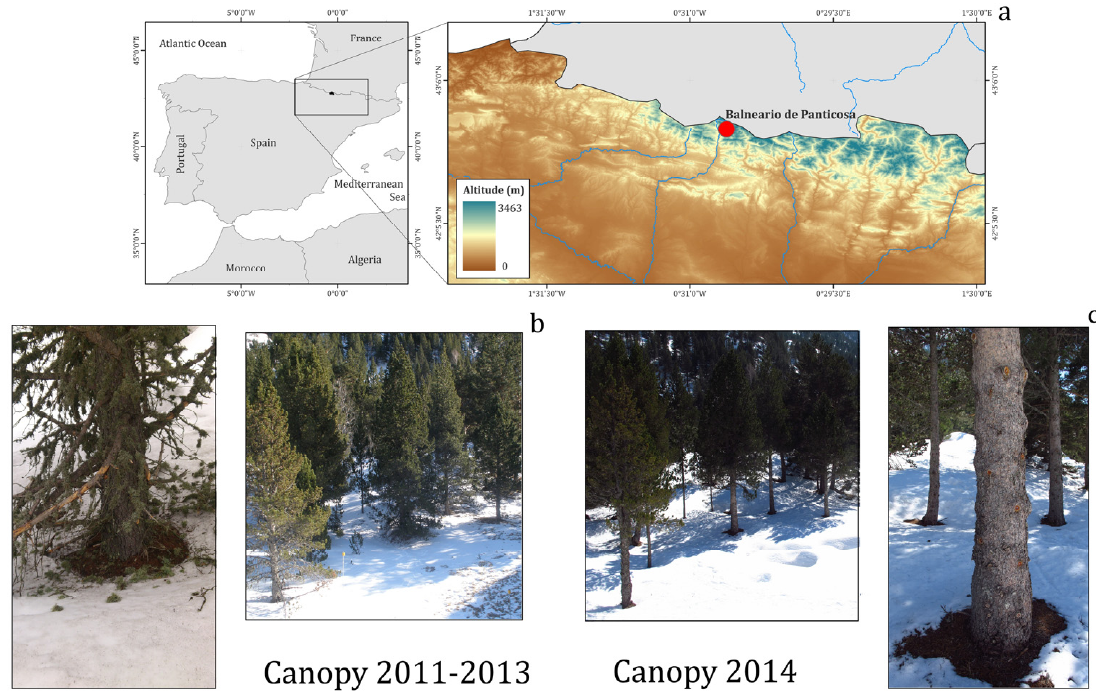
Figure 1. The Balneario de Panticosa study area ( a ) and crown-trunks comparisons prior to ( b ) and following ( c ) branch pruning.